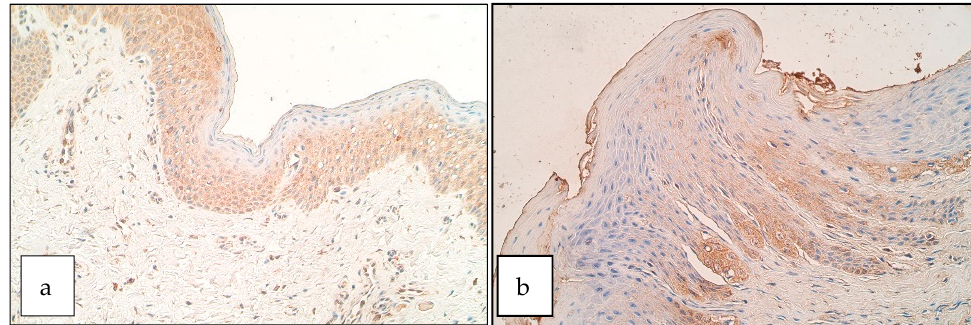
Figure 1. Immunoreactive structures for DLX4. ( a ) Moderate DLX4 positive structures in the patient epithelium, DLX4 IHM, 200 × . ( b ) Moderate DLX4 positive structures in the control group, DLX4 IHM, 200 ×.